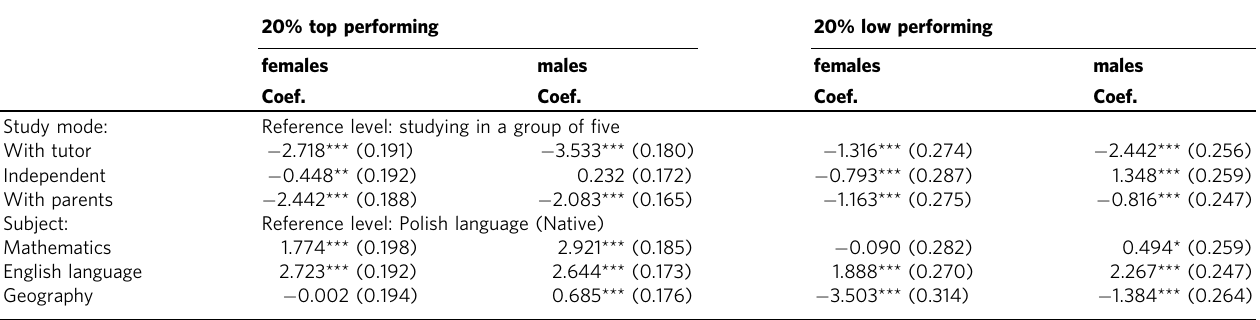
Table 6 Willingness to Pay (in hours) by the students ’ gender and achievement level. Reference levels: working in a group of fi ve for study mode attribute and Polish language (Native) for subject attribute.